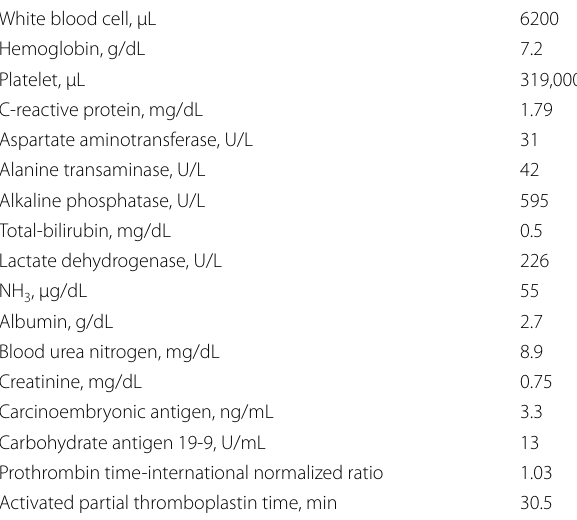
Blood tests showed severe anemia, but hepatobiliary enzyme levels and tumor markers were within normal